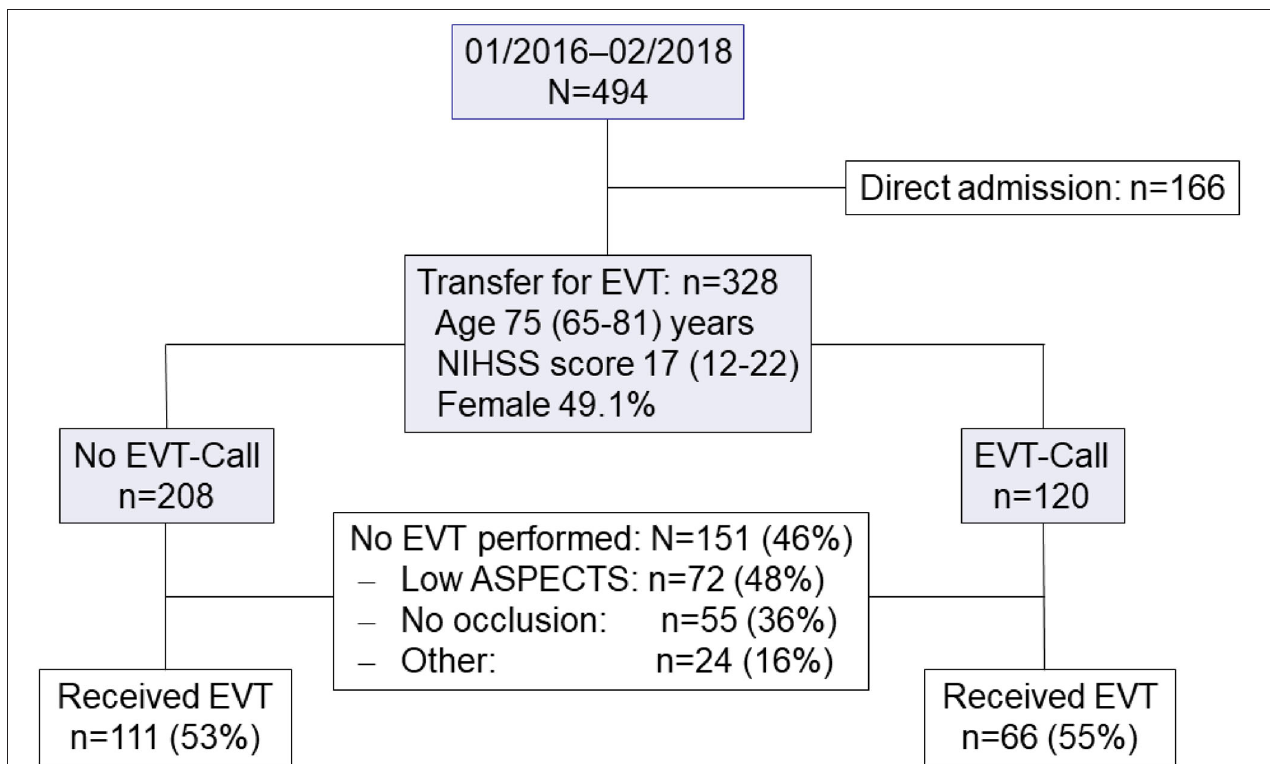
FIGURE 2 | Patient flow